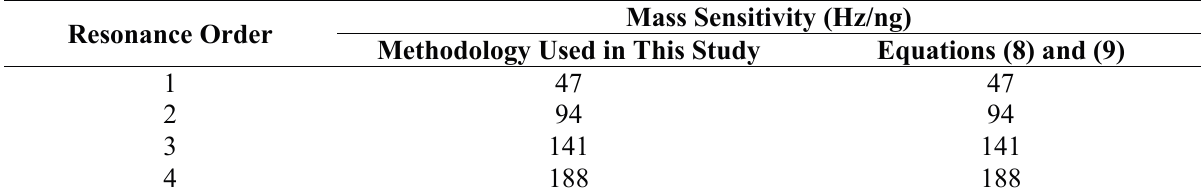
Table 3. Comparison of the mass sensitivity for a / l =1 calculated by the two methods. Resonance Order